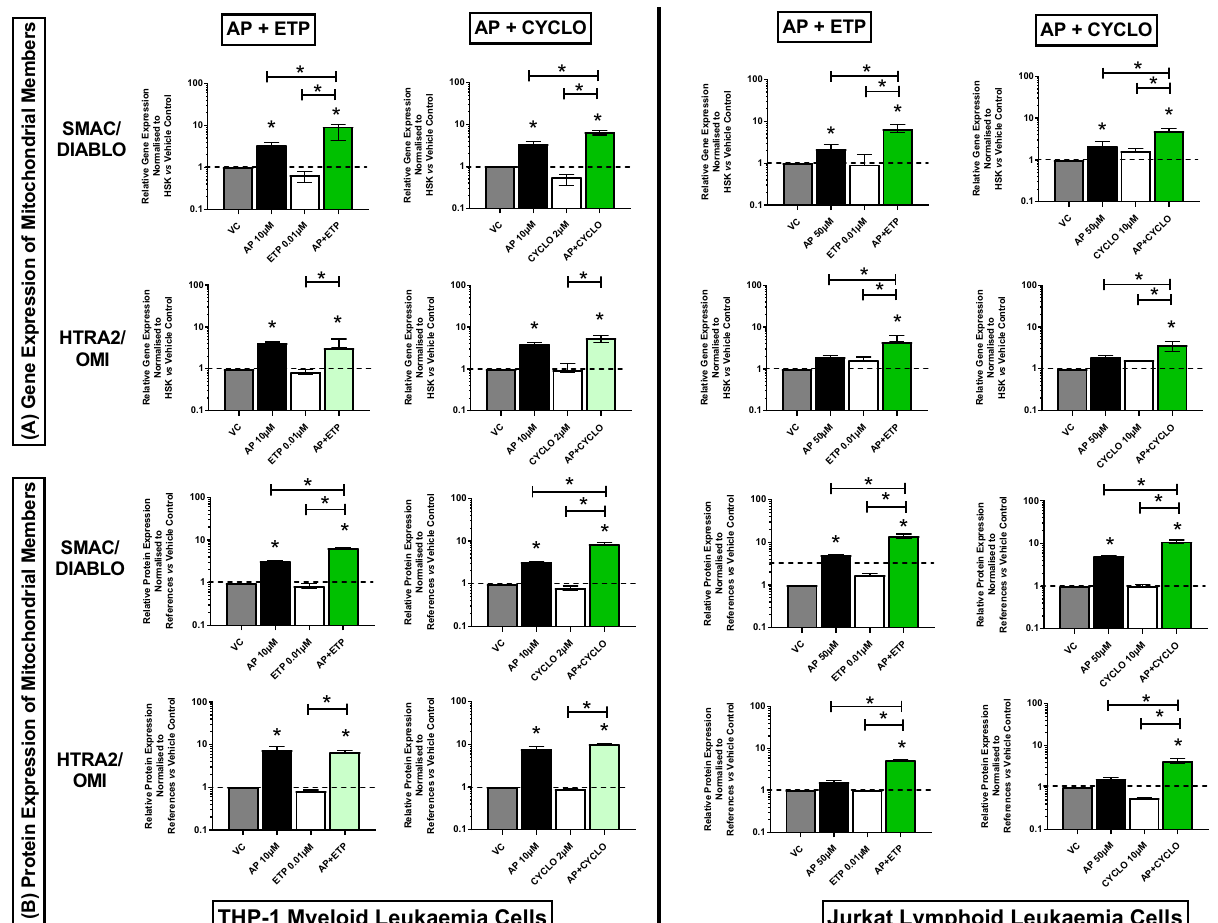
Figure 4. Effects of apigenin (AP) alone and in combination with etoposide (ETP) and cyclophosphamide (CYCLO) on expression of SMAC/DIABLO and HTRA2/OMI mitochondrial genes ( A ) and proteins ( B ) in acute myeloid (THP-1) and lymphoid (Jurkat) leukaemia cell lines when treated with their lowest significant doses (LSDs) that induce apoptosis (determined previously in Mahbub et al., 2013, 2015, 2019) for 24 h. Gene and protein data are expressed as medians and ranges. Results were considered statistically significant when P ≤ 0.05 (*). The combination treatment effects and colours were determined based on the statistical analysis described